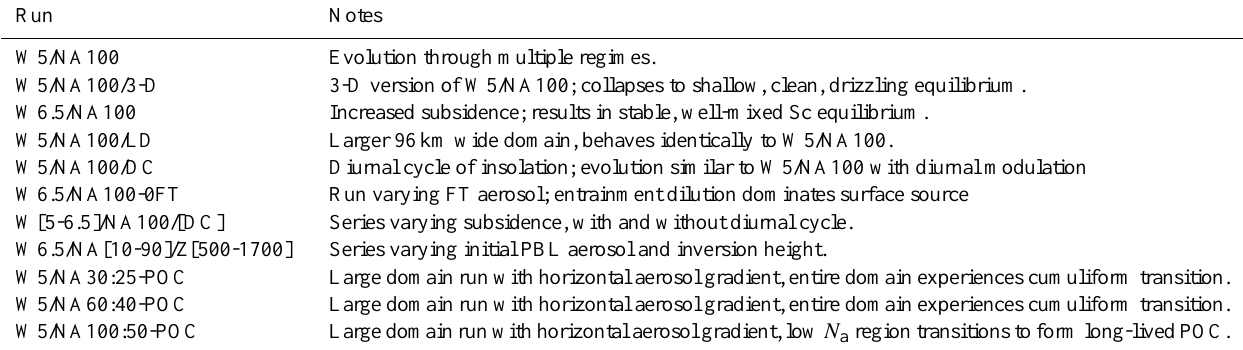
Table 1. List of runs performed in this study. Run names concatenate the large-scale subsidence forcing W at 1500m given in mms − 1 , followed by initial PBL aerosol concentration NA in # mg − 1 , followed by any other modifiers for sensitivity studies. All runs use identical thermodynamic initialization, a FT aerosol concentration of 100mg − 1 and a 24km horizontal domain size, except where noted. POC runs are 192km wide and are initialized with equally sized regions of higher and lower aerosol concentration given by the two numbers after